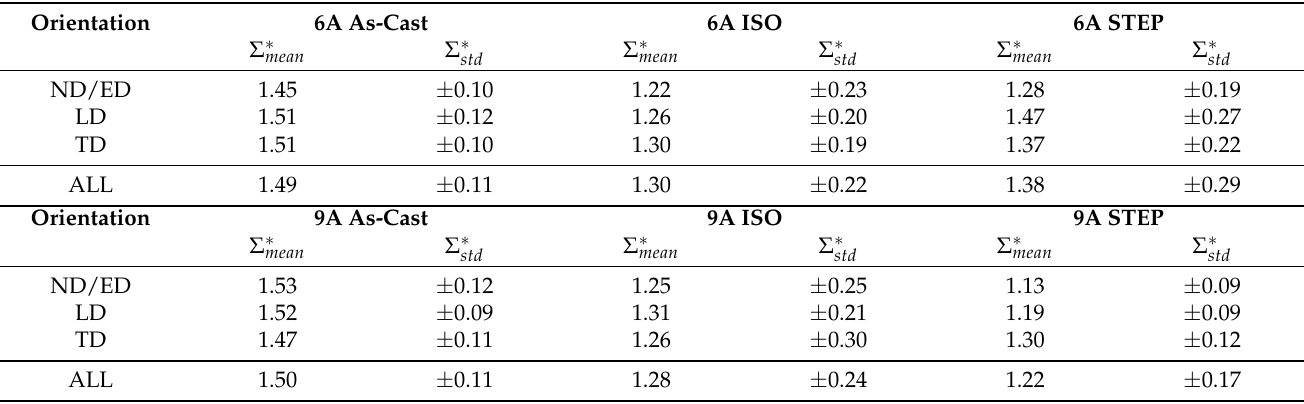
Table A2. Spall strength mean values and standard deviations. A summary of the orientation-specific and sample-specific Σ ∗ mean values and standard deviations. All values are expressed in units of